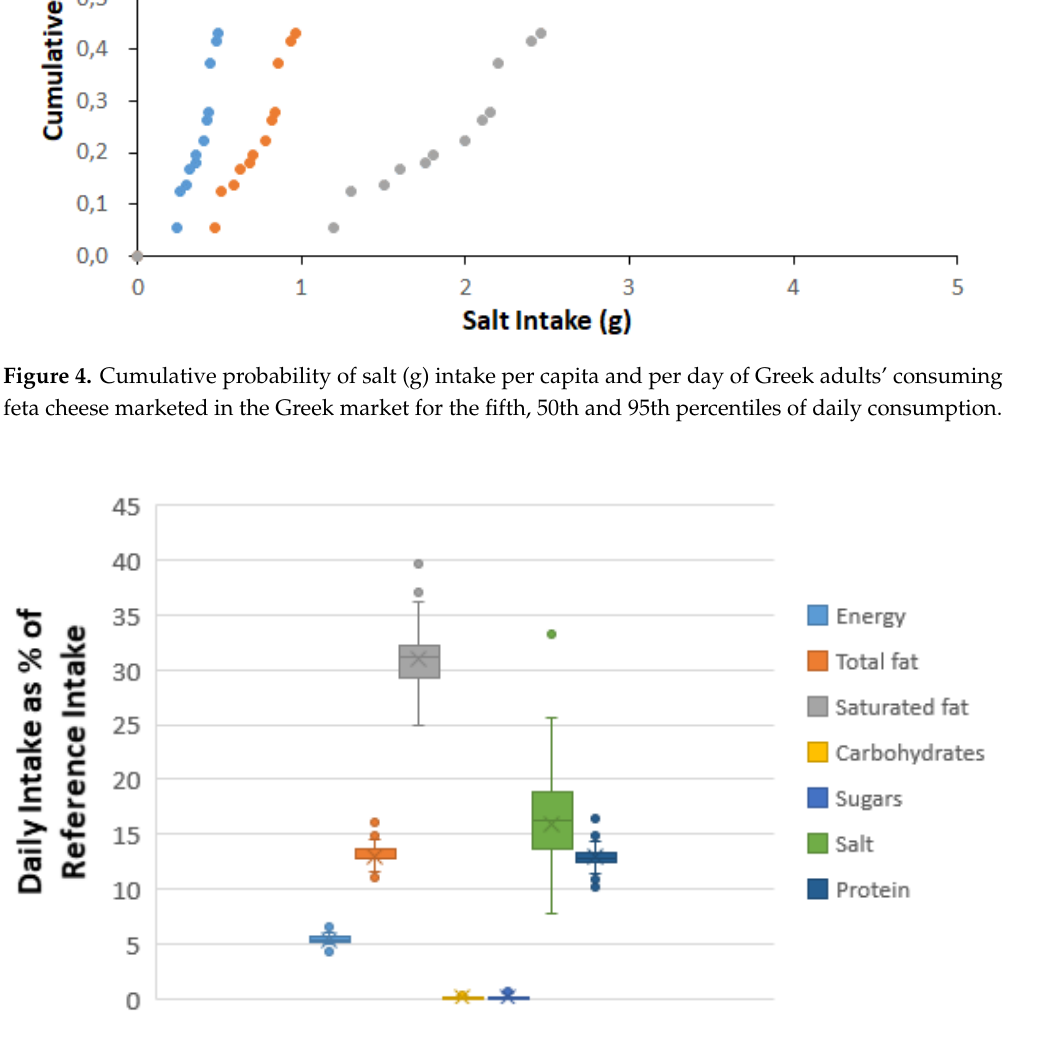
Figure 5. Daily intake per capita as a percentage of European daily reference intakes (RIs), for the 50th percentile of the daily consumption of prepacked feta cheese marketed in the Greek market .